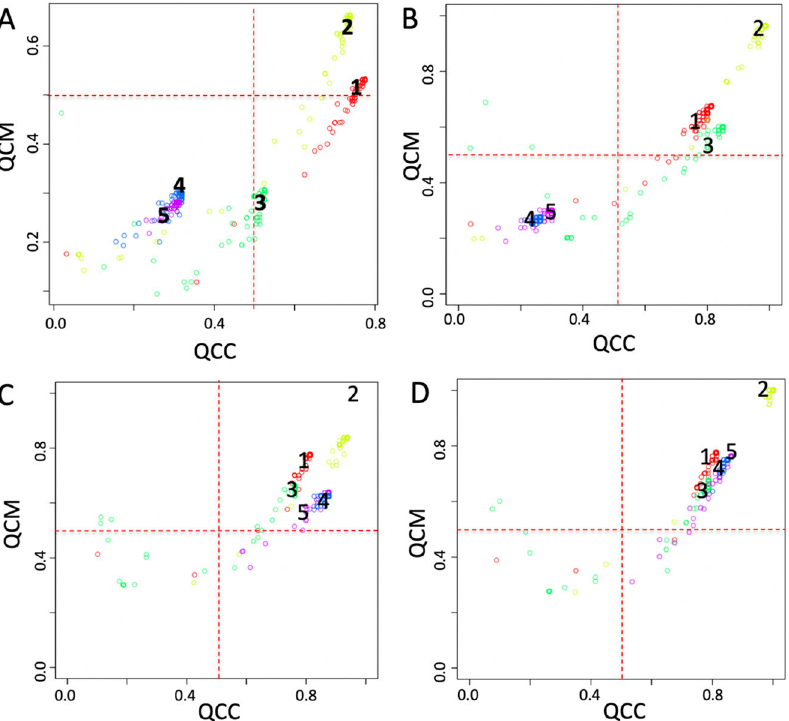
Fig. 5 QCM/QCC plots for SSCA. a TF latent space. b TF + miRNA latent space, ( c ) TF + miRNA + IS latent space, ( d ) TF + miRNA + IS + Kinase latent space. Input counts table for SCA is log10